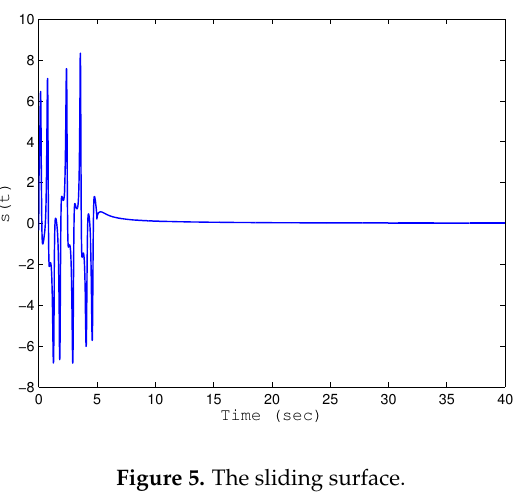
Figure 5. The sliding